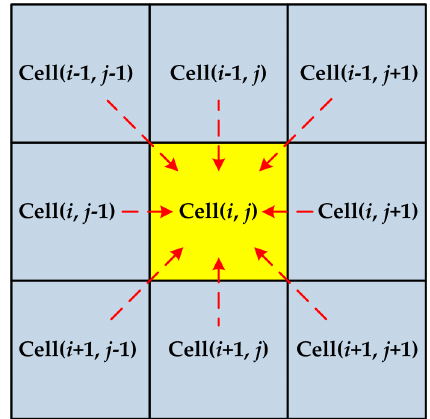
Figure 6. Moore neighbor in 2D Cellular Automata.